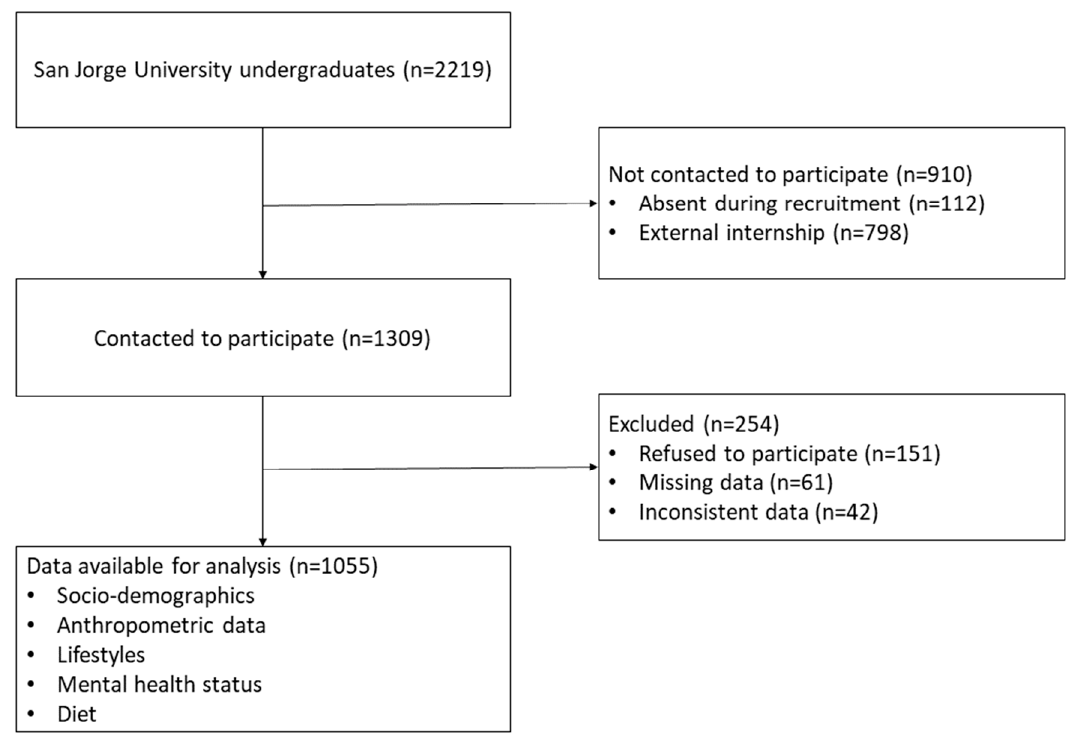
Figure 1. Study flow chart.